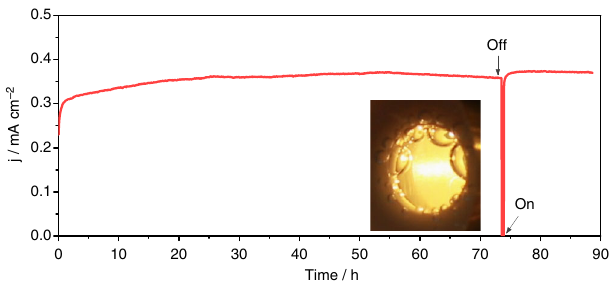
Fig. 5 Stability test on H-NiO x . The chronopotentiometric curve obtained with the H-NiO x photoelectrode in 4.0 M NaOH + 1.0 μ M Ir-anion at 1.23 V RHE under AM 1.5 illumination. A chopped light operation with 20 min interval was performed after 73 h of continuous stability test. The image of the photoanode window (inset) exhibits a bubble evolution/coverage on the surface of the Ni/Ir-decorated hematite